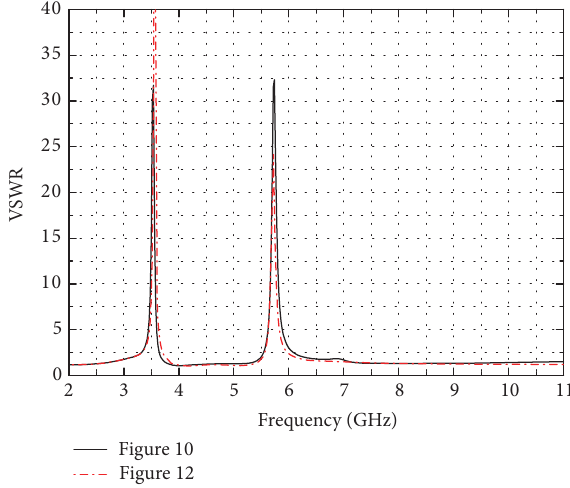
Figure 13: Simulated VSWR of Figures 10 and 12.